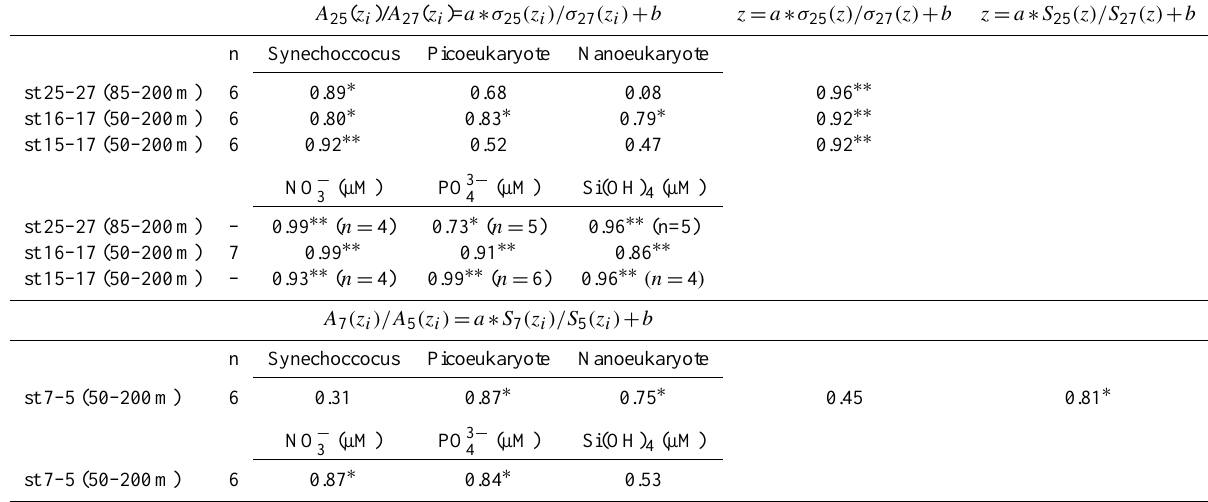
Table 4. Correlation coefficients ( R 2 ) of linear relationships between ratios at a given depth ( z i ) below 50m of cell abundance or nutrient concentrations A(z i ) and density excess σ ( z i ) or salinity S(z i ) at two compared stations. Linear relationships were also established between depth and the ratio of density excess or salinity at the two compared stations. The compared stations and the range of depth where the linear relationships were established are given in the first column. The linear relationships are explicitely written for stations 25 and 27 and for station 7 and 5 as two